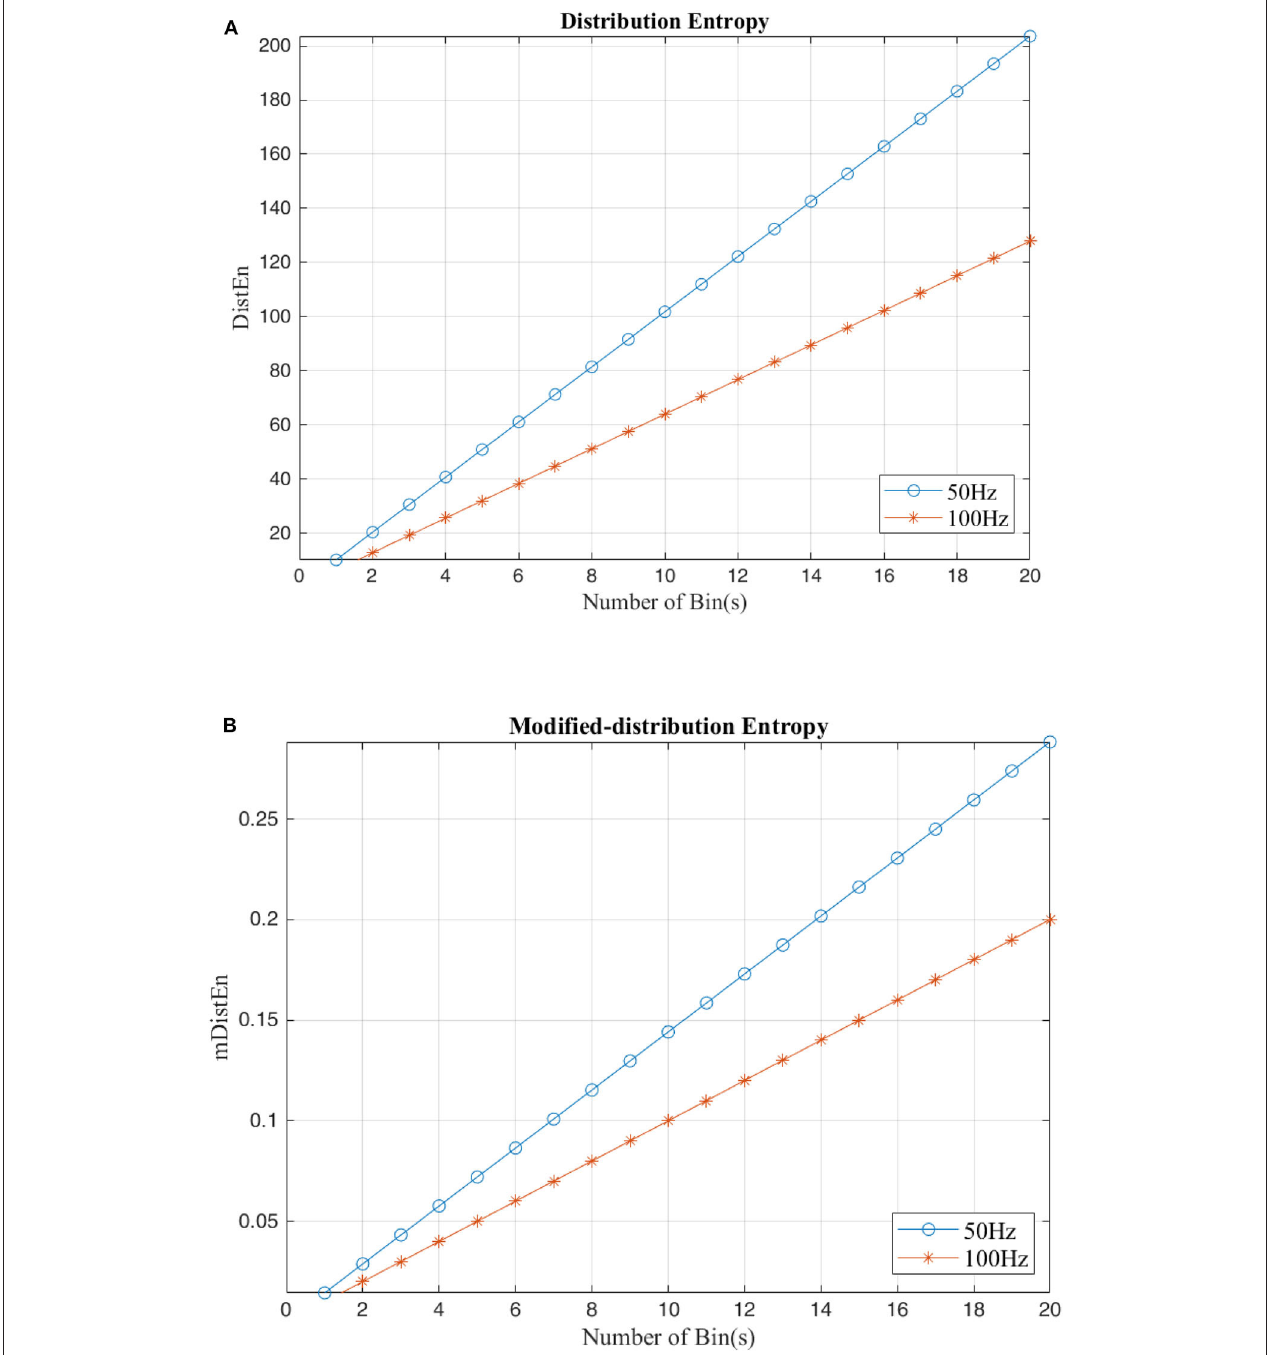
FIGURE 4 | Calculation of distribution entropy and the modified distribution entropy using a sinusoidal signal with difference frequencies (50 and 100Hz). (A) Distribution entropy. (B) Modified-Distribution